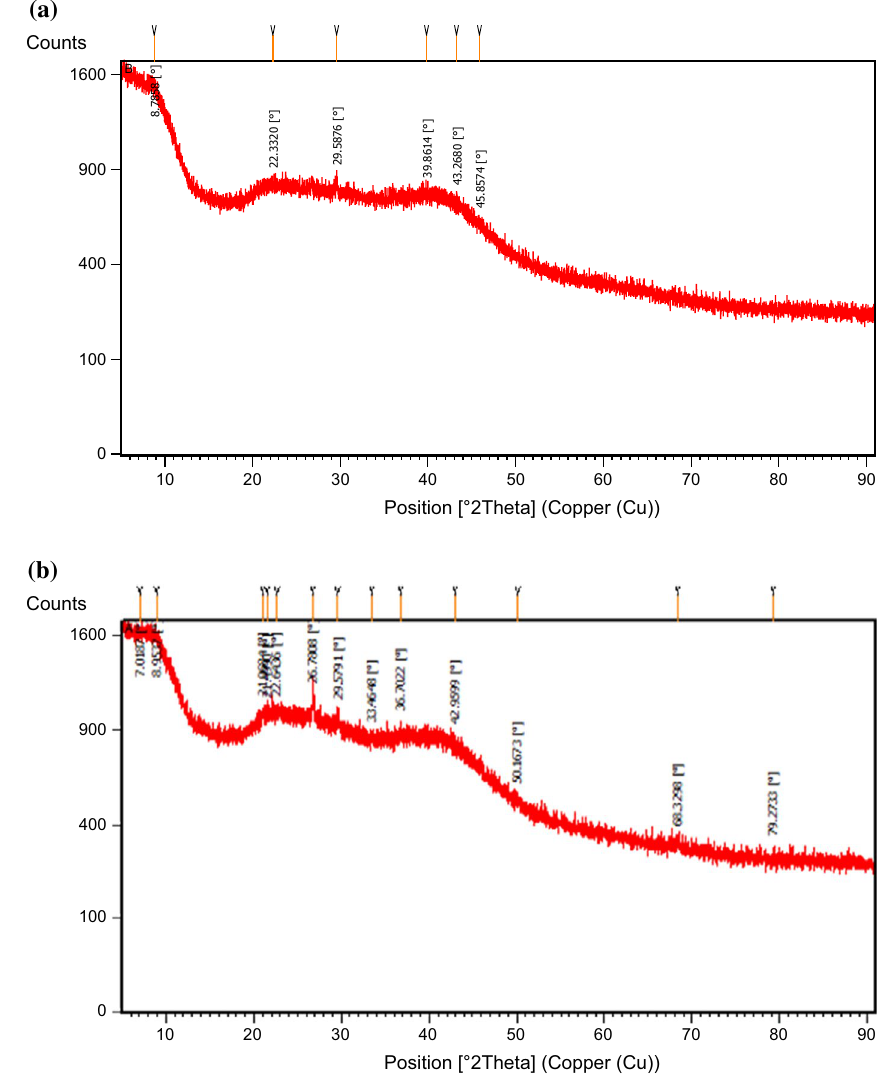
Fig. 2 XRD pattern of a untreated and b treated with Cd(II) N.